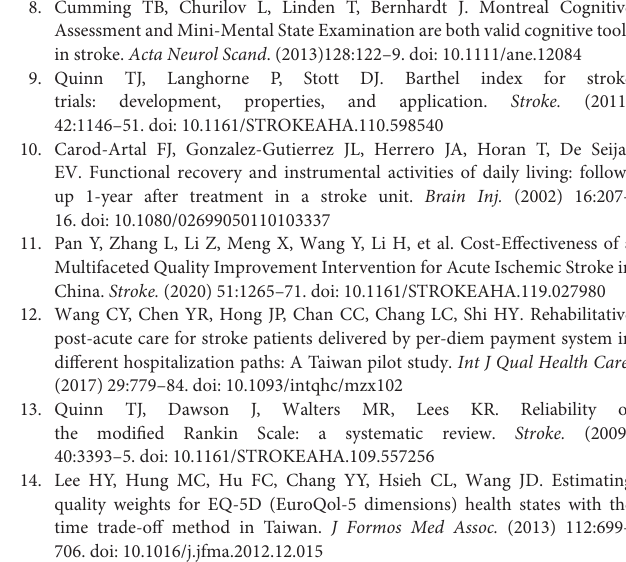
Supplementary Figure 1 | Comparison by LS-mean ± SE of each functional status measure between PAC and non-PAC groups, after controlling for baseline, week 6 and 12, and 1 year data and comparison of trend in each functional status measure between the groups. Utility_TW, Utility (Taiwan); Utility_UK, Utility (United Kingdom); MMSE, Mini-Mental State Examination; BI, Barthel index; IADL, Instrumental Activities of Daily Living; FOIS, Functional Oral Intake Scale; BBS, Berg Balance Scale; PAC, postacute care; LS-mean, least squares mean; SE,